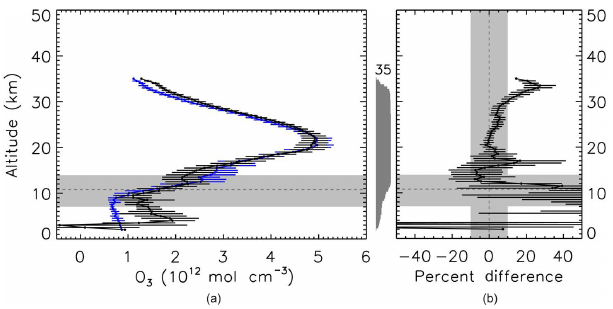
Figure 4. Similar to Fig. 2 but for the average difference of co- incident pairs for SAGE III-ISS and Hohenpeißenberg ozonesonde profiles obtained from June 2017 to May 2018.